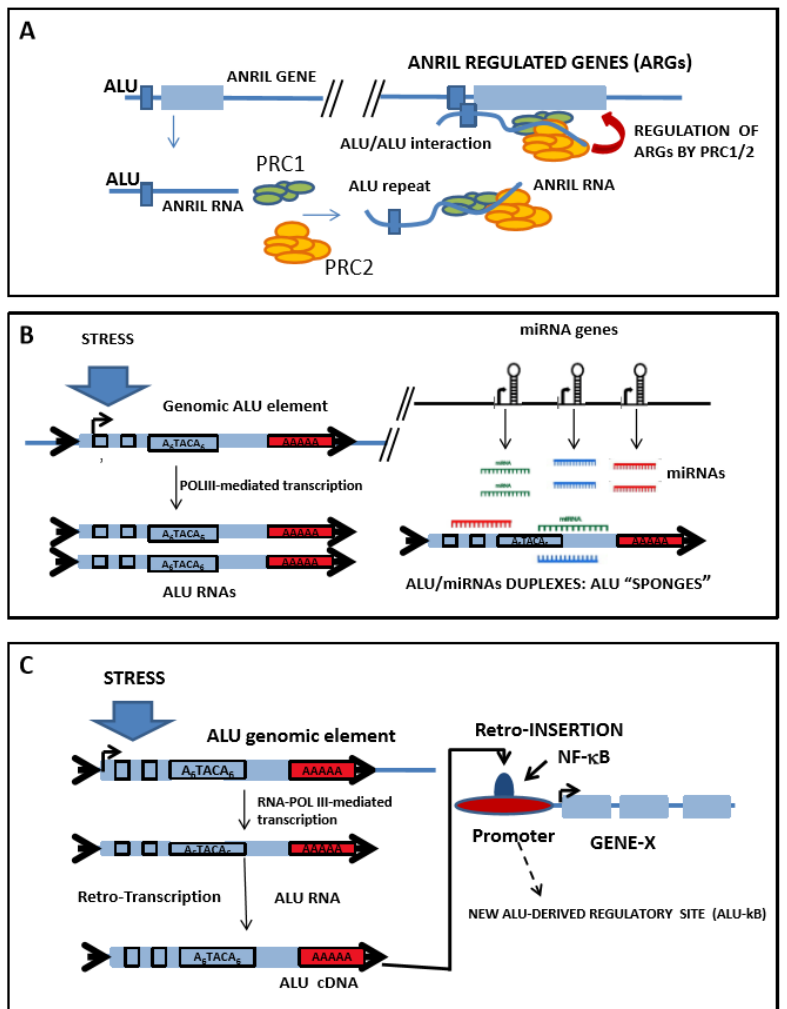
Figure 2. Possible mechanisms through which the Alu repeated sequences impact Atherosclerosis (ATH) progression. ( A ) Alu elements regulate the function of antisense noncoding RNA in the INK4 locus ( ANRIL ), a risk factor for atherosclerosis and cardiovascular disease (CVD). ANRIL RNA, which harbors Alu elements, is transcribed, recruiting polycomb repressive complexes 1 and 2 (PCR1/2), and interacting with other genes via an “ Alu – Alu ” or “ Alu –alternative site” direct interaction, thus facilitating the regulation of their expression through PRC1/2. Taken from Reference [77]. Graphic not drawn to scale. ( B ). Alu -RNAs could behave as microRNA (miRNA) sponges, creating complex regulatory networks that are altered in diseases. Shown here are the main elements implicated in the Alu /miRNA regulatory loop, namely: Alu genes, free Alu -RNAs, miRNA genes, and miRNAs. The postulated Alu –miRNA interaction does not consider the folding of Alu elements, nor does it consider the existence of Alu miRNA-binding proteins that could impact the interaction. STRESS stands for any stimulus that upregulates the transcription of free Alu elements, such as glucocorticoids [78], human immunodeficiency virus (HIV) infection [79], adenovirus type 5 [80] or type 2 infections [71], herpes simplex virus infection [81], or heat shock [73]. Graphic not drawn to scale. ( C ). Several Alu elements are binding sites for transcription factors, such as nuclear factor kappa B (NF- κ B), and may impact the gene expression of the inflammatory response. Retrogressed Alu elements can function as NF- κ B binding sites, thus expanding the set of genes co-regulated by NF- κ B in the inflammatory response (see main text for details). Shown here are the main elements implicated in the Alu /NF- κ B regulatory loop, namely: Alu genes, free Alu -RNAs, Alu complementary DNAs (cDNAs), and their retrogression to gene regulatory regions. STRESS is defined as in ( B ). Dashed arrow shows a new Alu -derived regulatory site ( Alu - κ B). Graphic not drawn to scale.